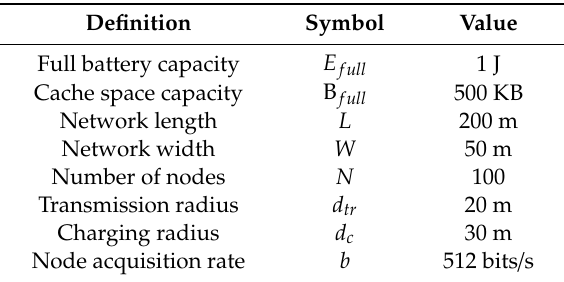
Table 2. Simulation parameters setting